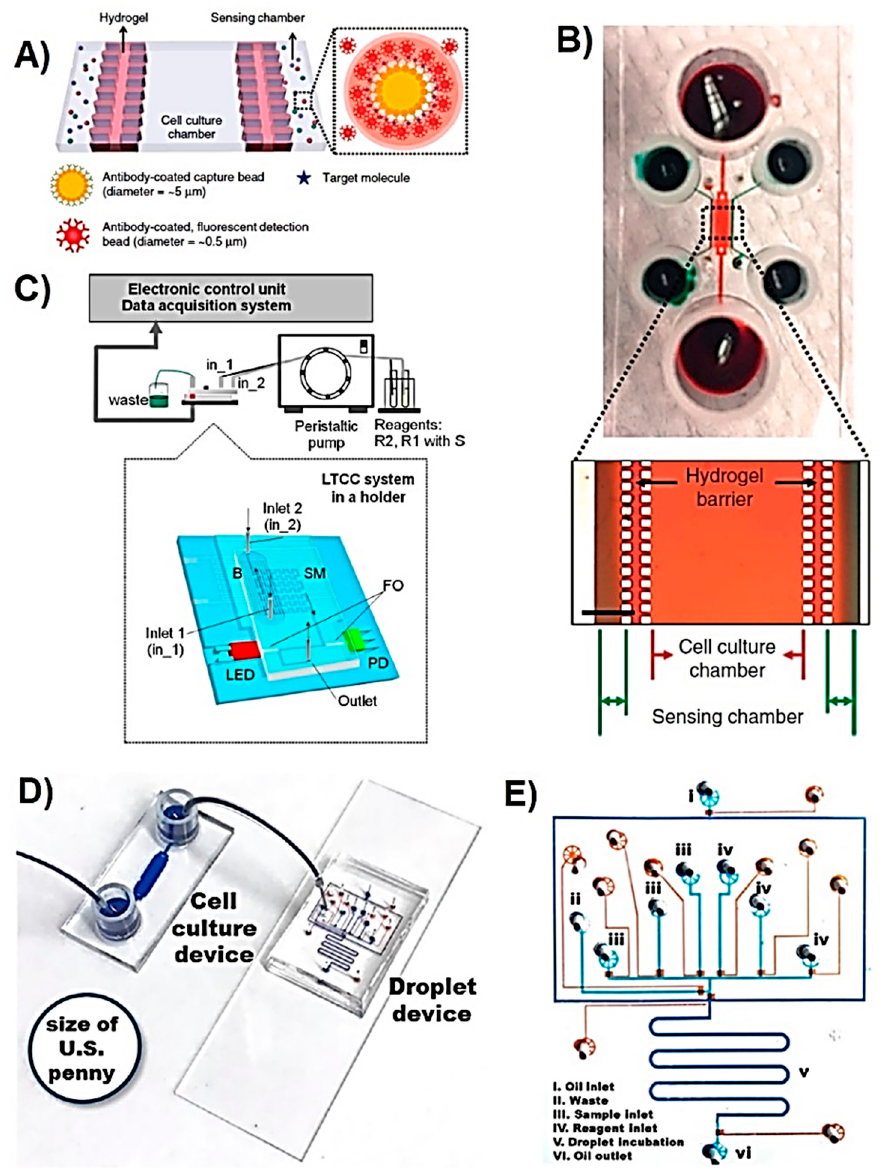
Figure 2. ( A ) Schematic of the microfluidic device containing a hydrogel barrier between the cell culture chamber (middle) and the sensing chambers (right-hand side). ( B ) A photograph and microscopic image of a microfluidic device containing red and green food dyes. Scale bar is 500 µ m, reprinted from [55]. ( C ) Scheme of the colourimetric urea measurement system: R1 with S—the first reagent R1 containing substrate—S (urea standard), R2—the second reagent, B—microreactor with immobilised urease, SM—serpentine type mixer, FO—optic fibre, LED—light emitting diode, PD—photodetector, reprinted from [51], copyright (2017), Springer Nature. ( D ) Photographs of hepatocyte-culturing microfluidic device and droplet device. ( E ) Photograph of droplet device, reprinted from [57], with permission from Elsevier, copyright (2019).